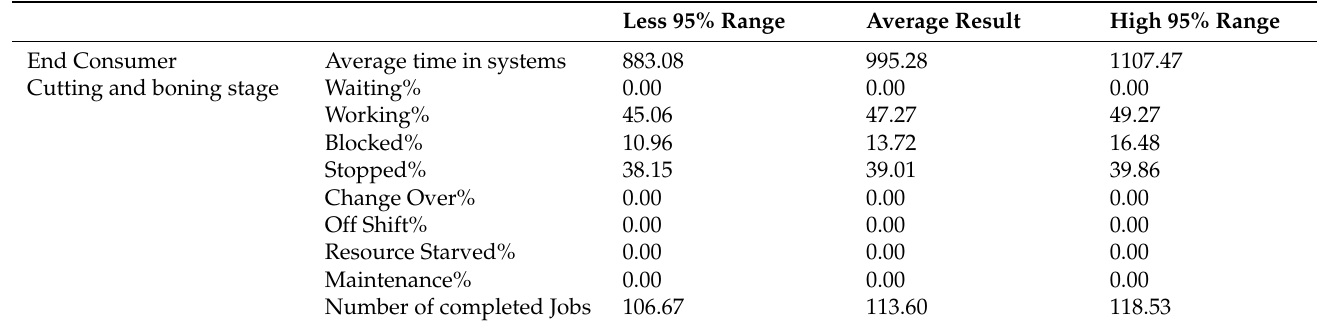
Table 4. KPI values for the beef supply chain simulated model.